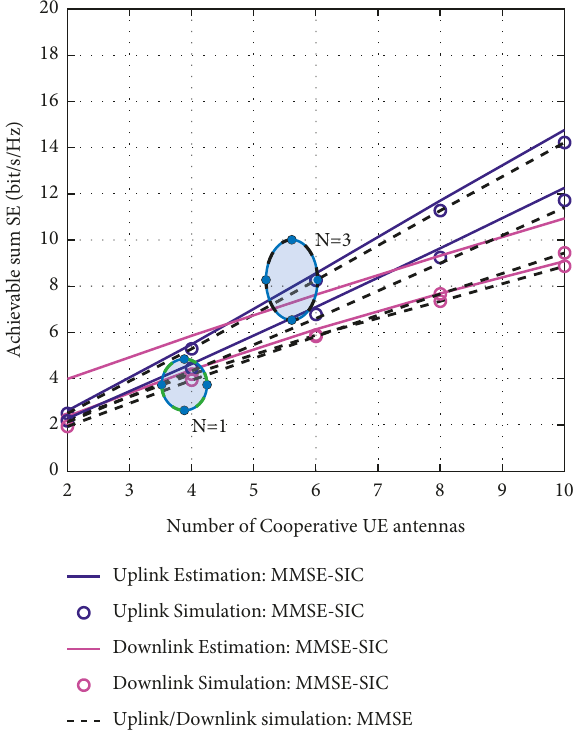
Figure 3: The total amount of obtained SE as a function of the number of PU antennas for. M � 2, ... , 10 in uplink, downlink for N � {1,3}, k � 10.